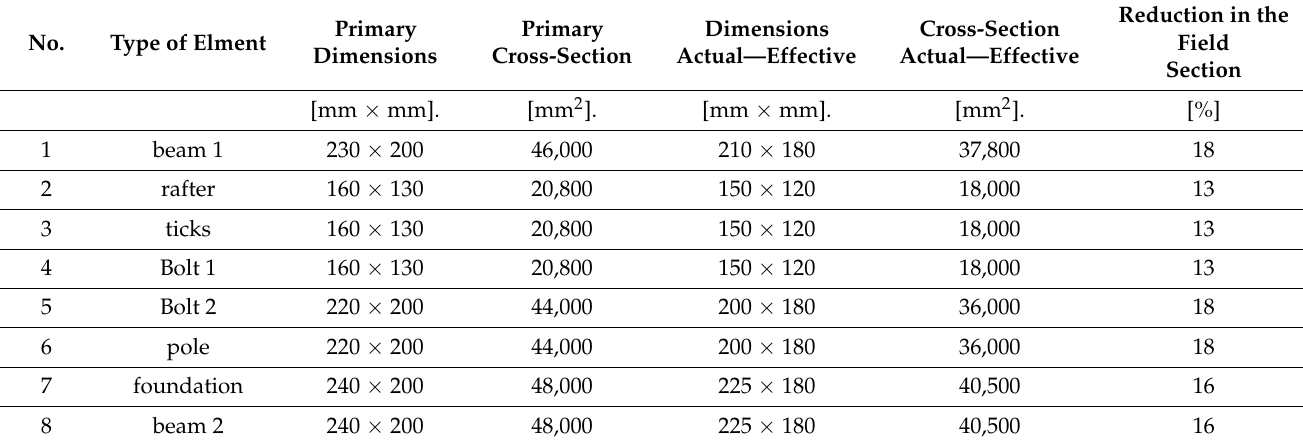
Figure 12. Construction model. Table 1. Cross-sectional dimensions adopted for static strength analyses in particular